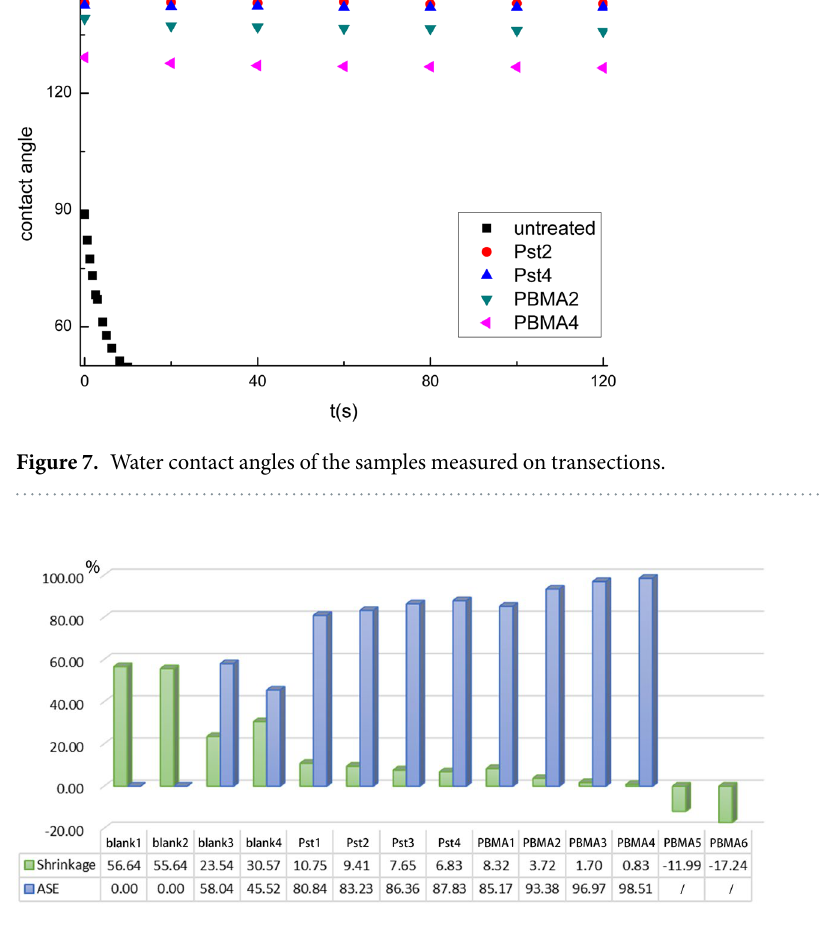
Figure 8. ASEs and shrinkages of the polymer grafted samples.